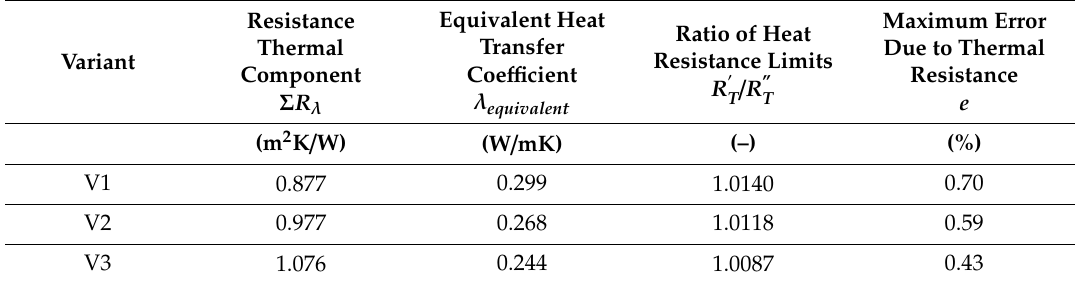
Table 4. Thermal parameters of the ceramic composite in the standardized calculation method (SCM). Resistance Thermal Variant Component Σ R